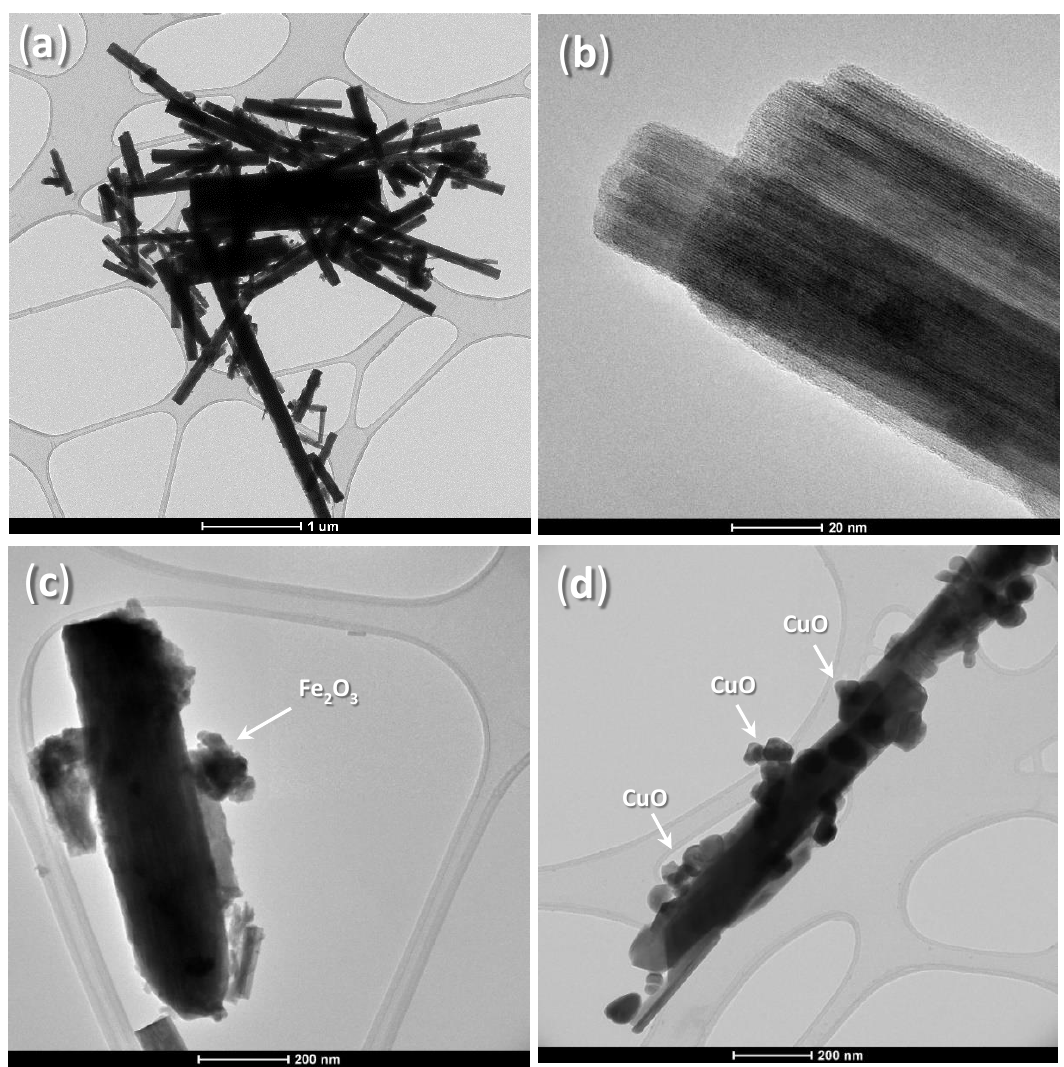
Figure 1. HRTEM images of pristine WO 3 NW ( a , b ) WO 3 NW@Fe 2 O 3 ( c ) and WO 3 NW@CuO ( d ) nanocomposite samples.